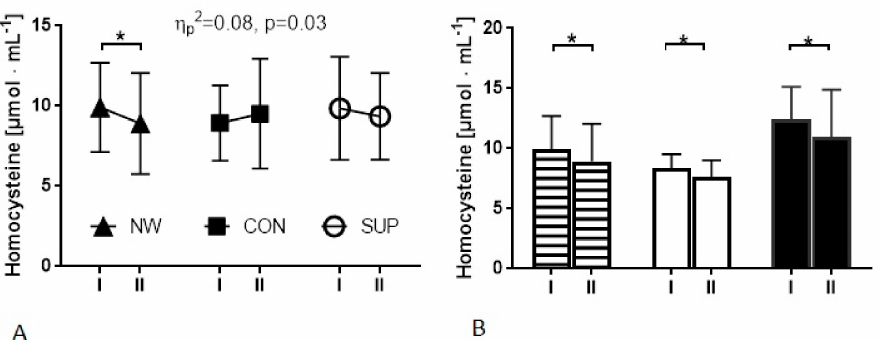
Figure 3. Changes in the resting homocysteine concentration in groups induced by the applied procedure. ( A ) I—at baseline, II—after 12weeks in NW, control and supplemented groups. ( B ) Analysis only in the NW Group; marked columns—all participants from the NW group, white columns—participants from the NW group with a baseline homocysteine ≤ 10 µ mol · L − 1 , black